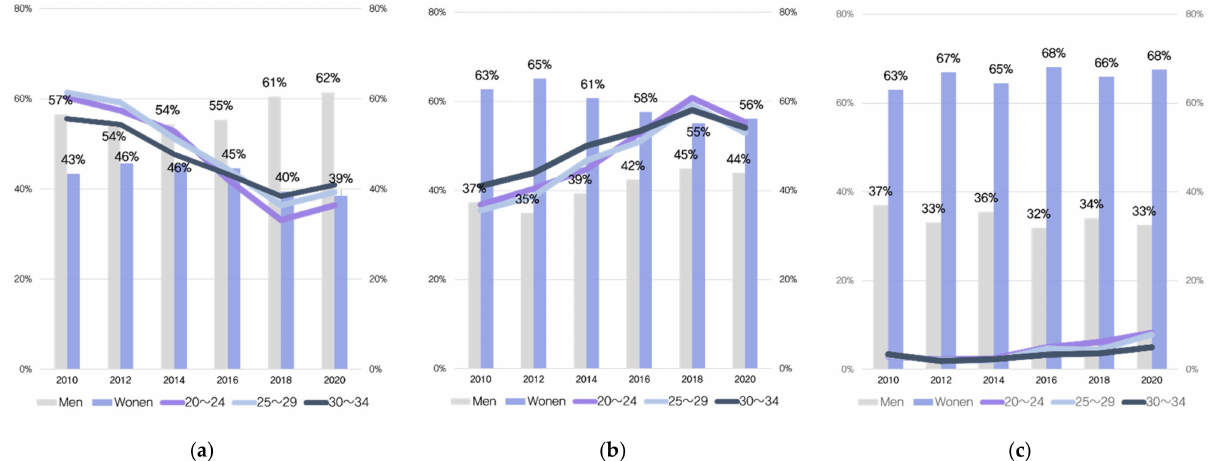
Figure 1. Changes in unmarried young adults’ (aged 20–34) intentions to marry by year: ( a ) positive marital intentions, ( b ) neutral marital intentions, and ( c ) negative marital